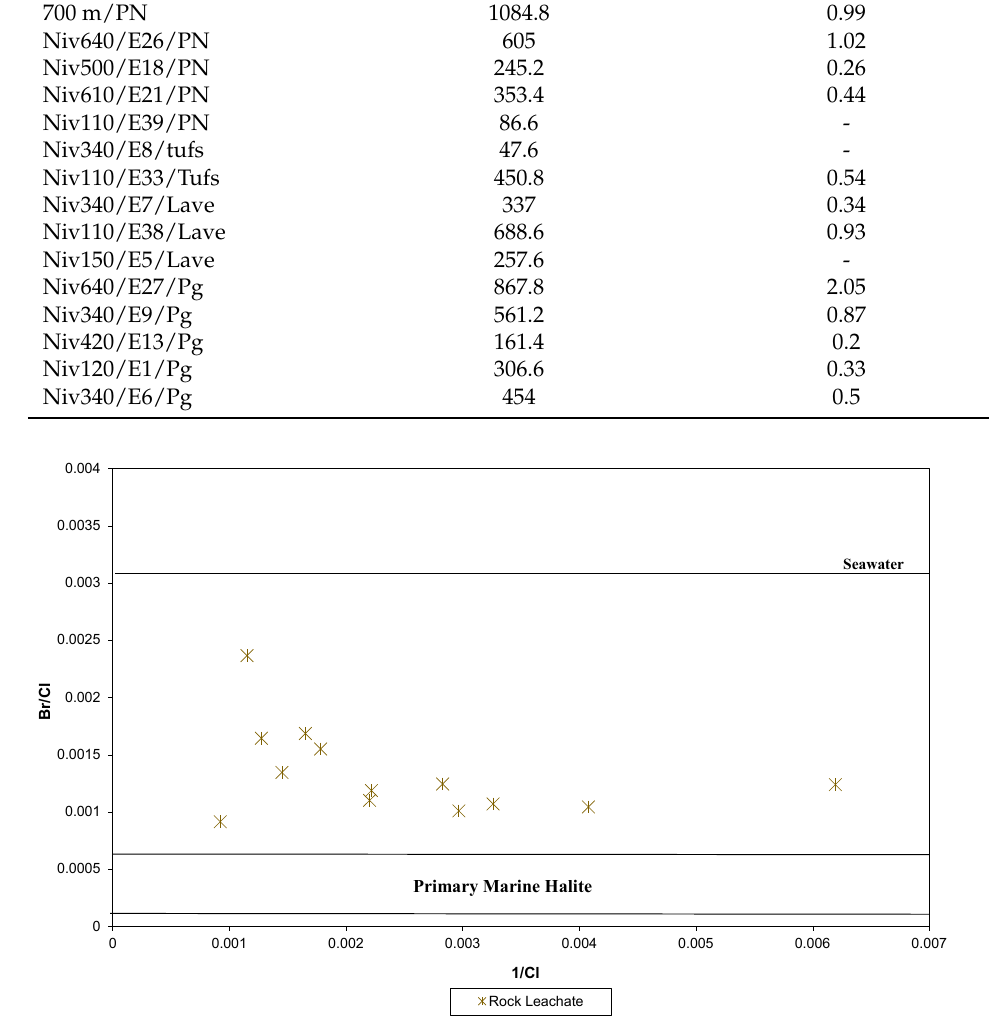
Figure 8. Plot of Br − /Cl − versus 1/Cl − of rock leachate.